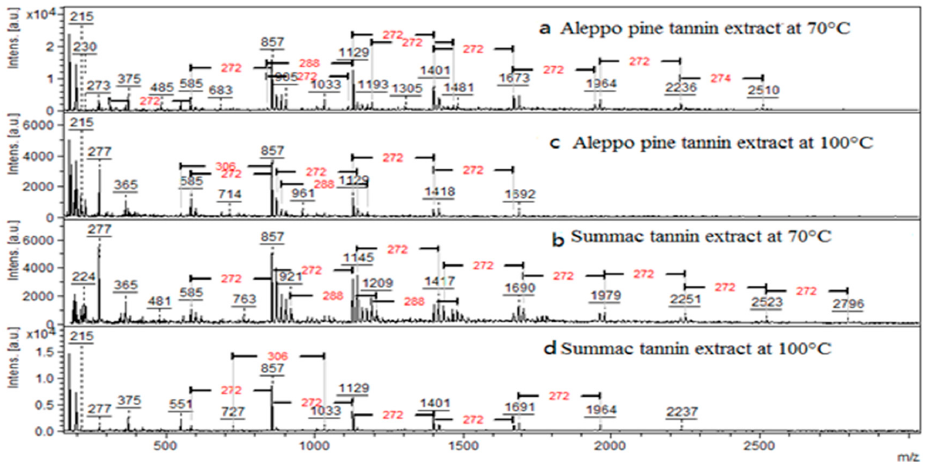
Figure 3. MALDI-TOF mass spectra of Aleppo pine extracts ( a , c ) and sumac extracts ( b , d ) obtained in positive ion mode between 160 m / z and 3000 m / z .